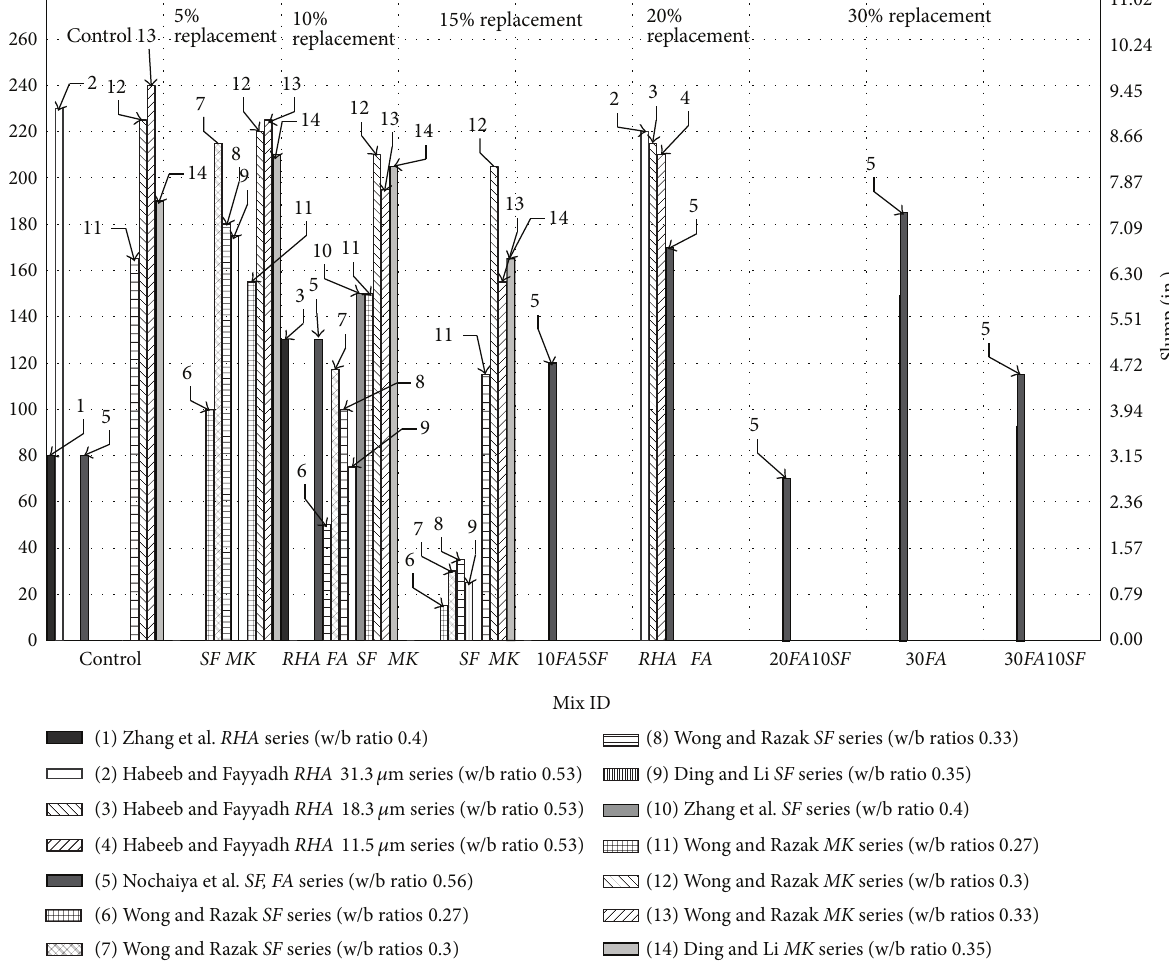
Figure 6: Slump of concrete with mineral